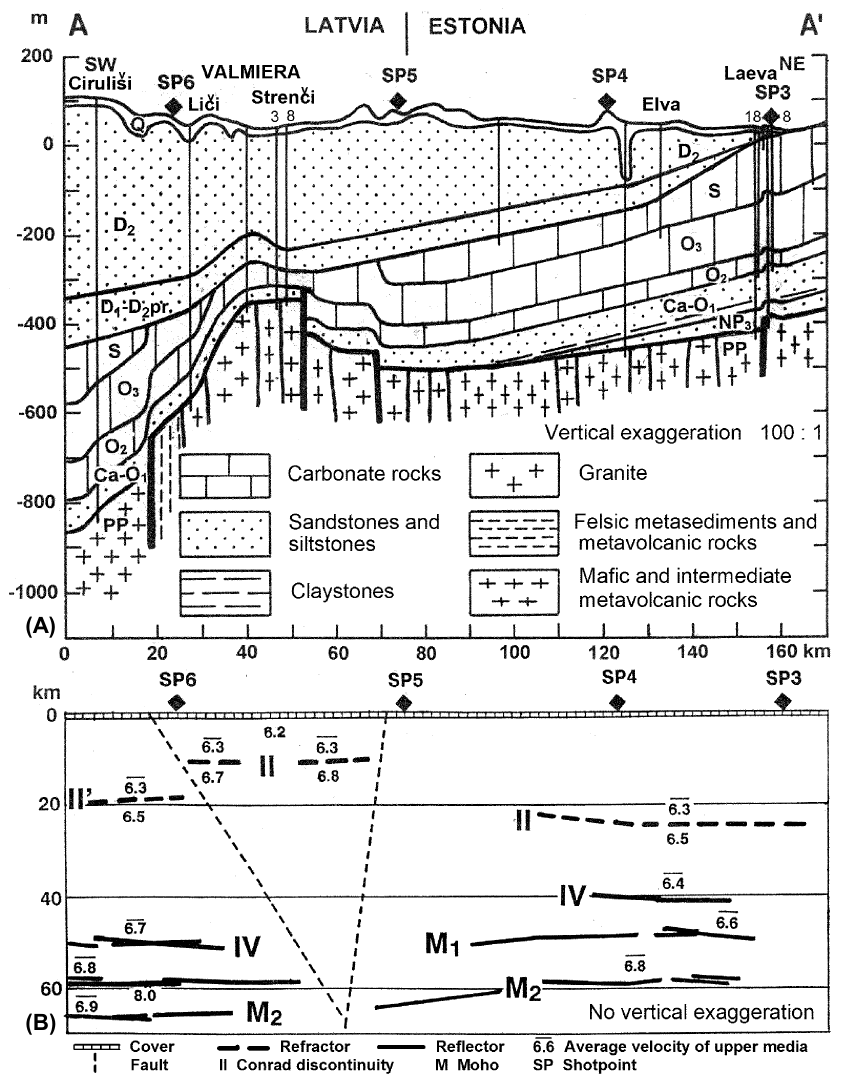
Fig. 8. Geological cross section ( A ) and deep seismic profile interpretation ( B ) (modified from Puura & Vaher 1997 and Ankudinov et al. 1994, respectively), across the VLU with the Valmiera Uplift. For location see Fig.